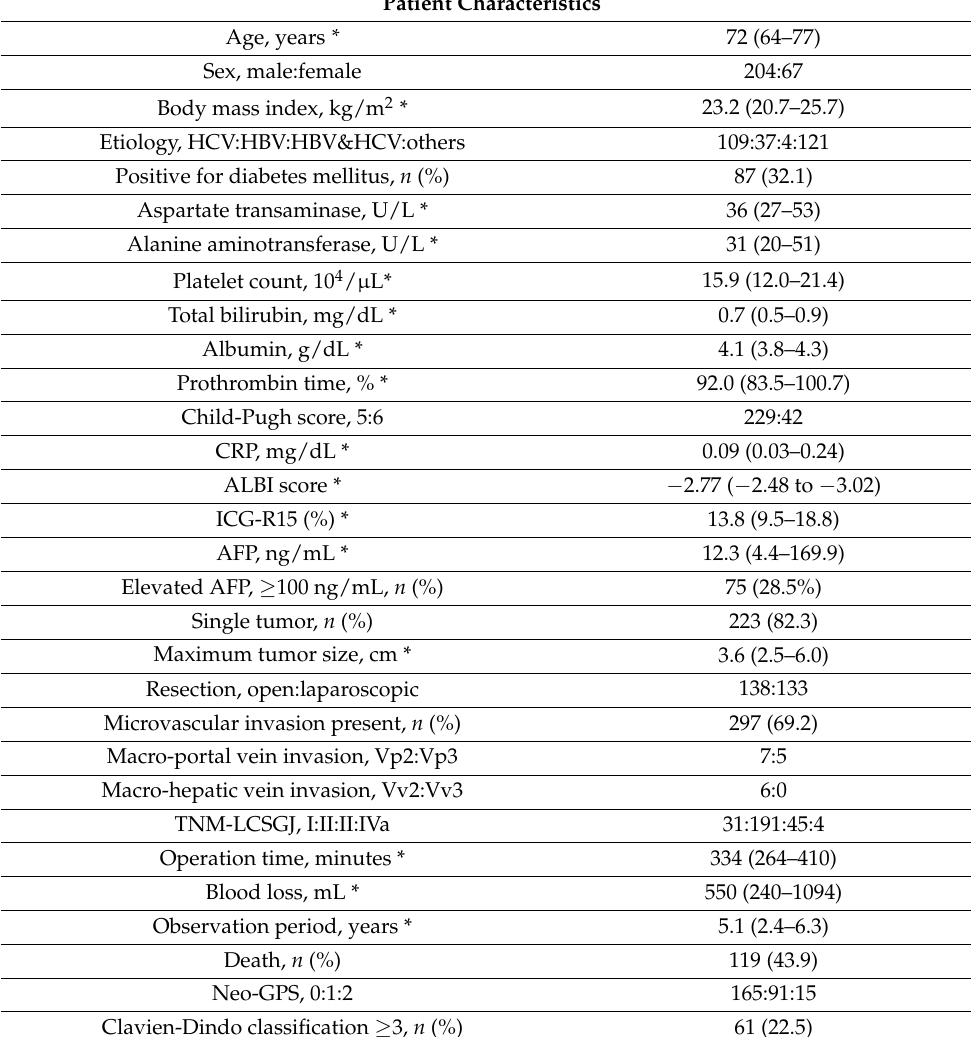
Table 1. Characteristics of patients ( n =